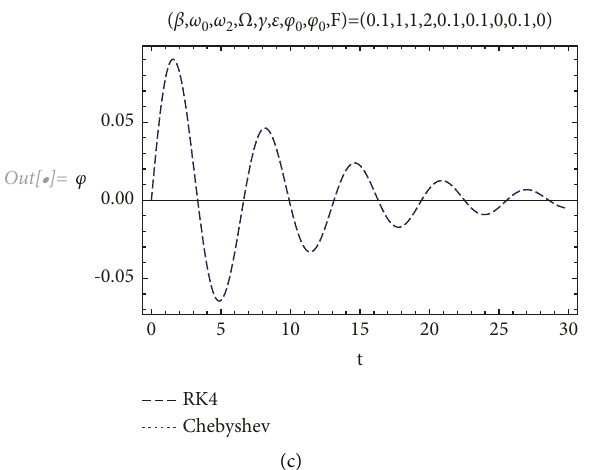
Figure 5: The comparison between the analytical approximation (16) and the numerical approximations using the Chebyshev collocation method and RK numerical method as well as the MATHEMATICA command Fit to i.v.p. (3) for case (3):